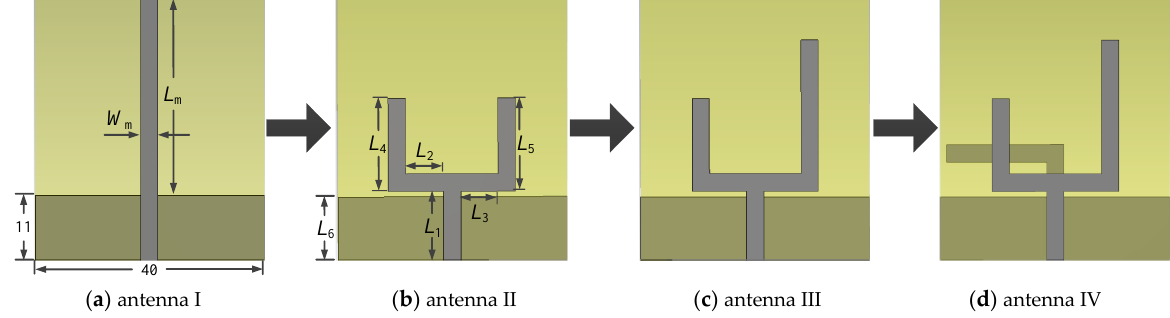
Figure 2. Evolution stages of the proposed antenna.